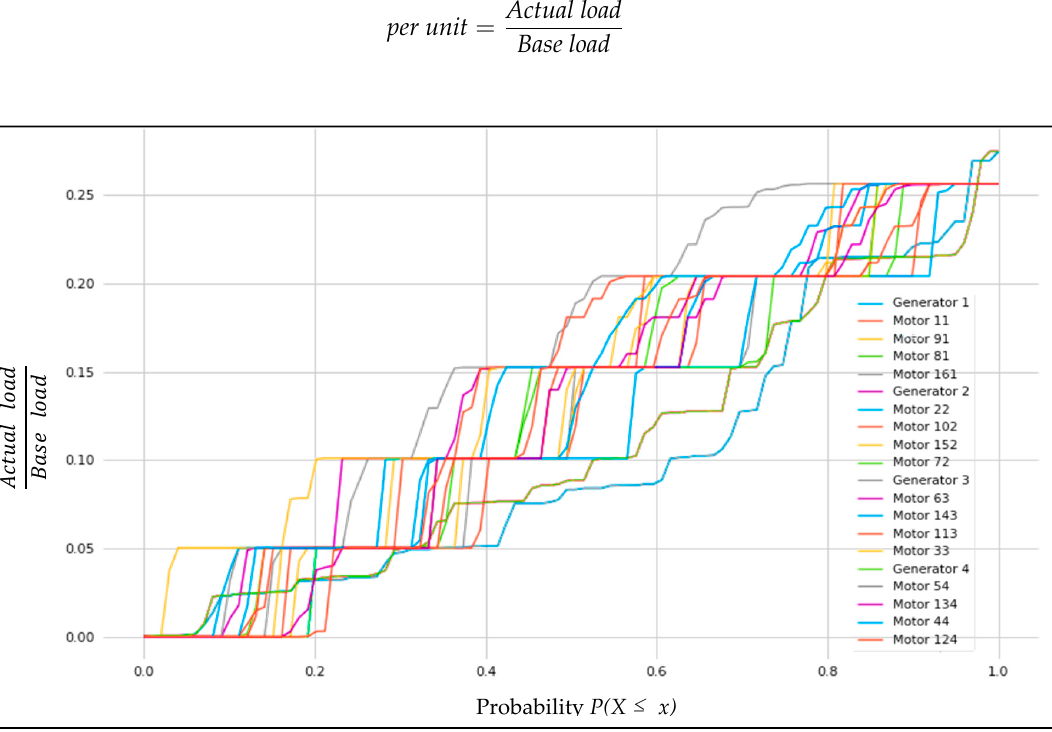
Table 4. Generator probabilities.